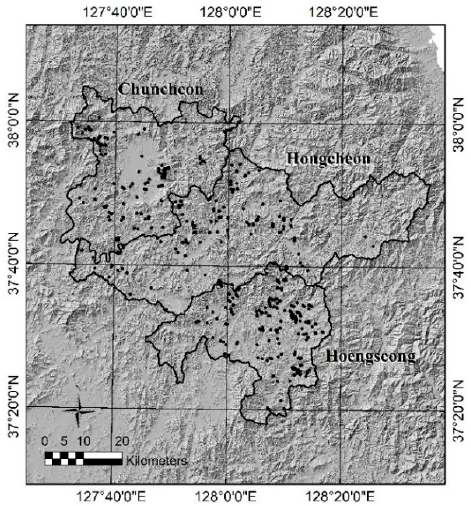
Figure 4. Landslide locations in the study area. The landslide inventory data were parts of the second and third rounds of data collection in Gangwon Province.